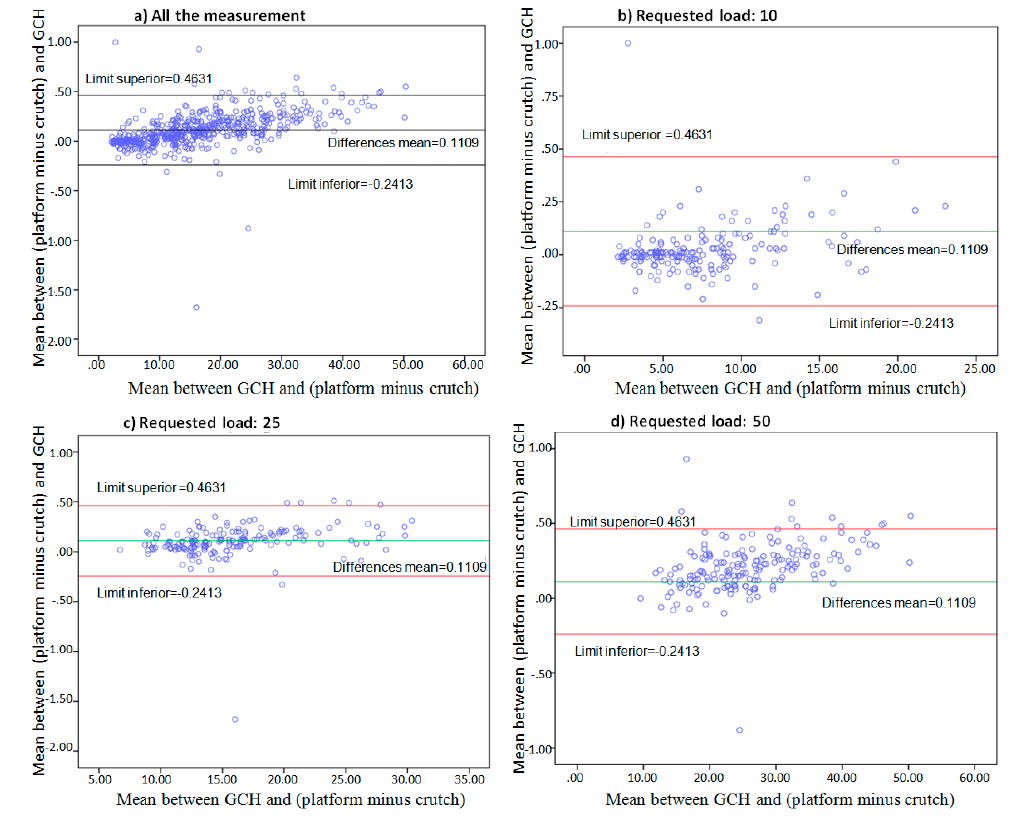
Figure 5. Bland-Altman Method representing the values differences (platform minus crutch) and GCH, versus the means (platform minus crutch) and GCH; for all the measurements ( a ), measurement requesting load on the crutches at 10% of body weight ( b ), 25% ( c ) and 50% ( d ). ANOVA, with p < 0.001, determined the existence of a linear relationship between both variables.